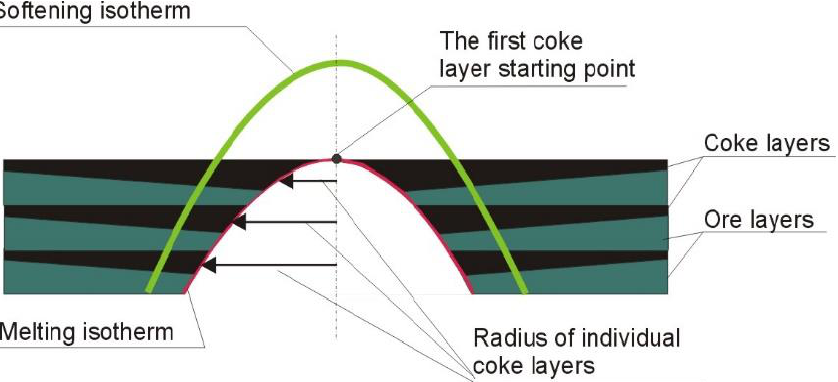
Figure 6. Coke layers calculation